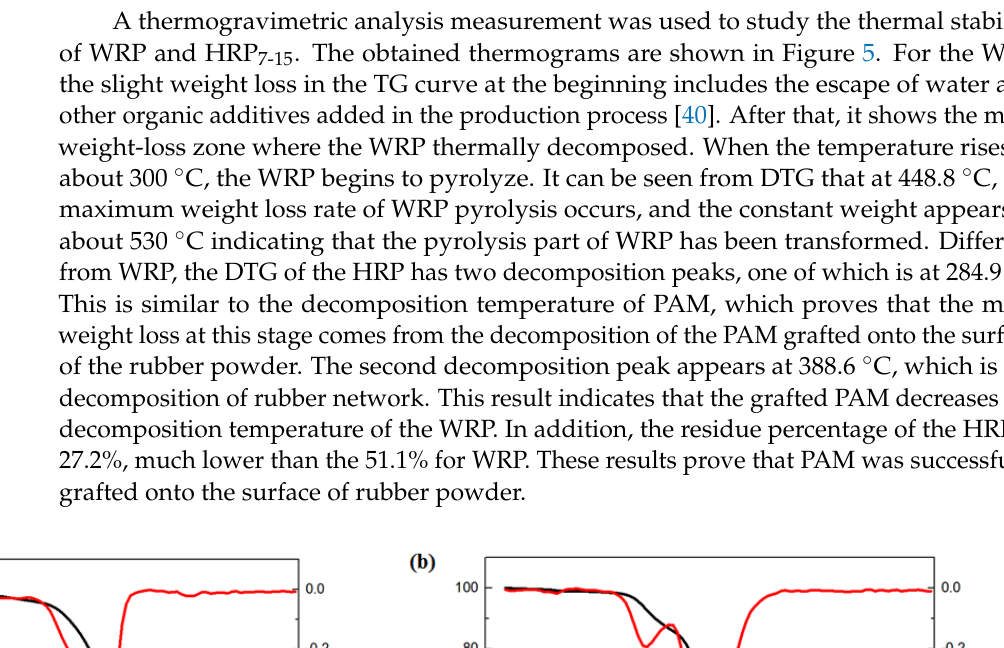
Figure 6. The setting time of WRP and HRP (a ) and the photo of HRP solution after 4 h with suspension agent ( b ) and without ( c ).